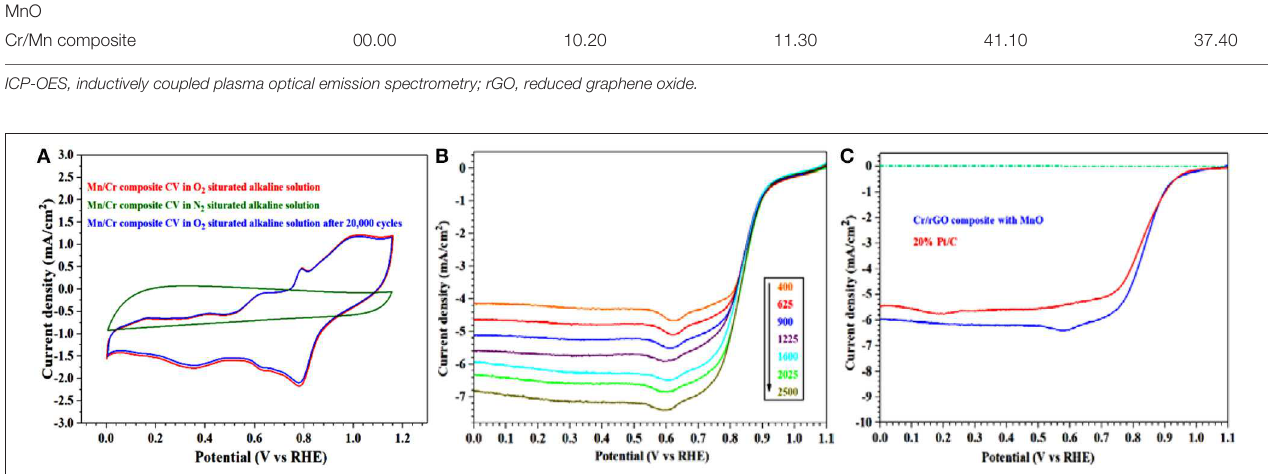
FIGURE 9 | Cr/rGO nanocomposite with MnO. (A) CV curves obtained at a scan rate of 50 mV · s − 1 in O 2 - and N 2 -saturated 0.1M KOH solution. (B) LSV curves in O